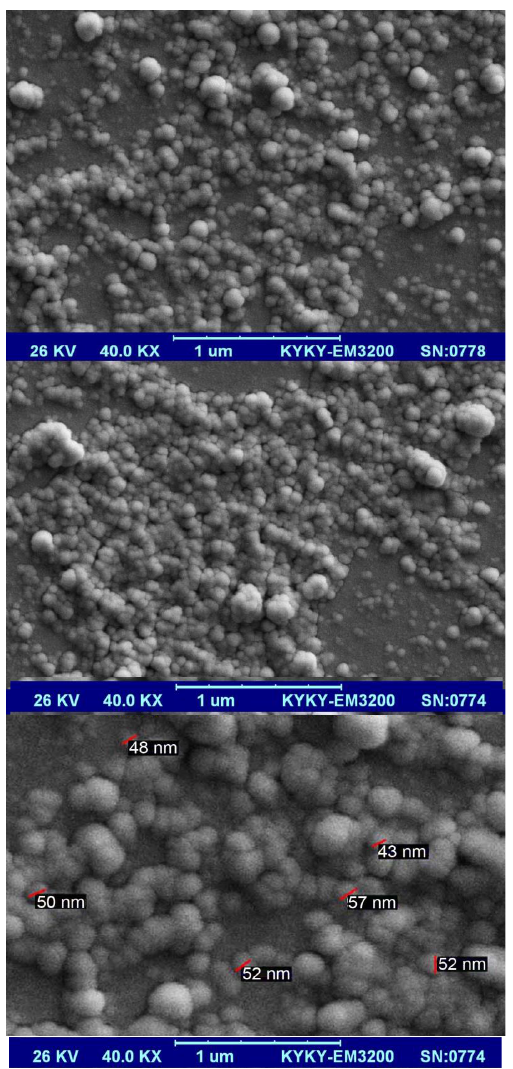
Fig. 5. SEM images of nanoparticles obtained by CTAB